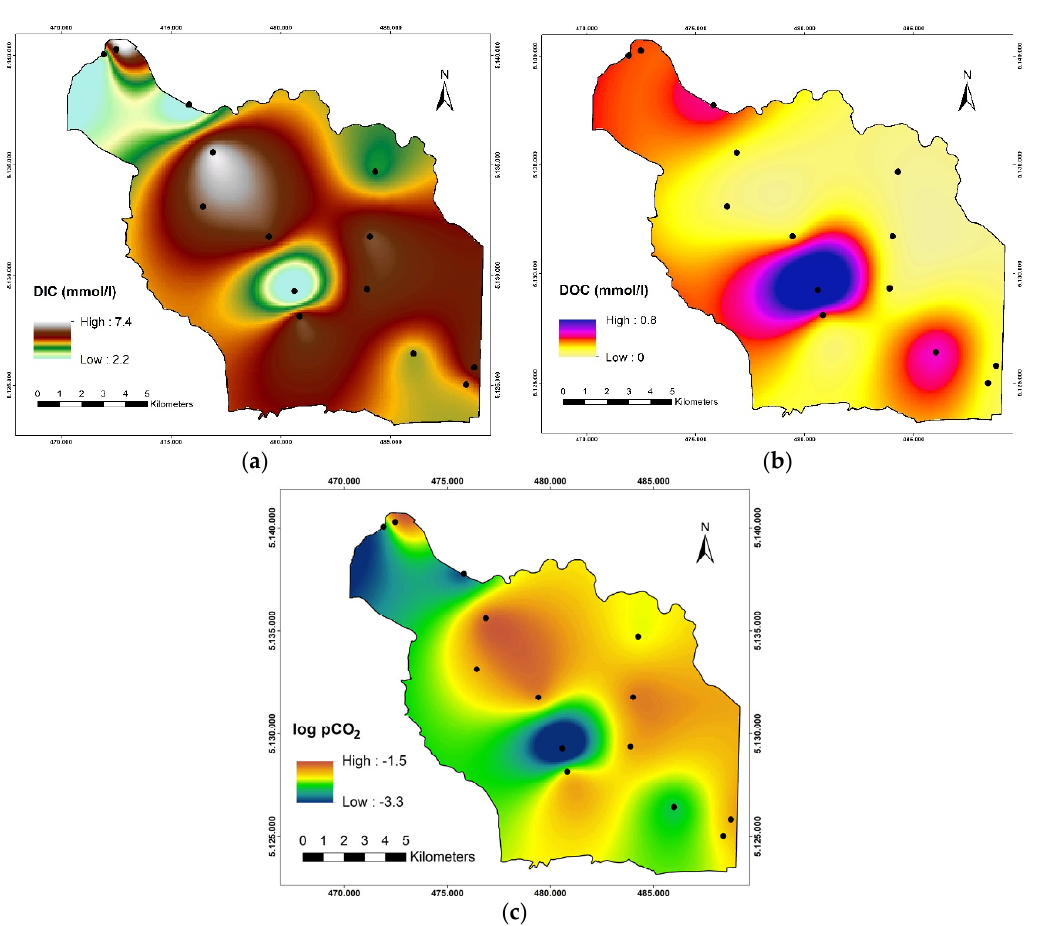
Figure 4. Spatial distribution of average values within Varaždin SW–GW system: ( a ) DIC; ( b ) DOC; ( c ) log pCO 2 .